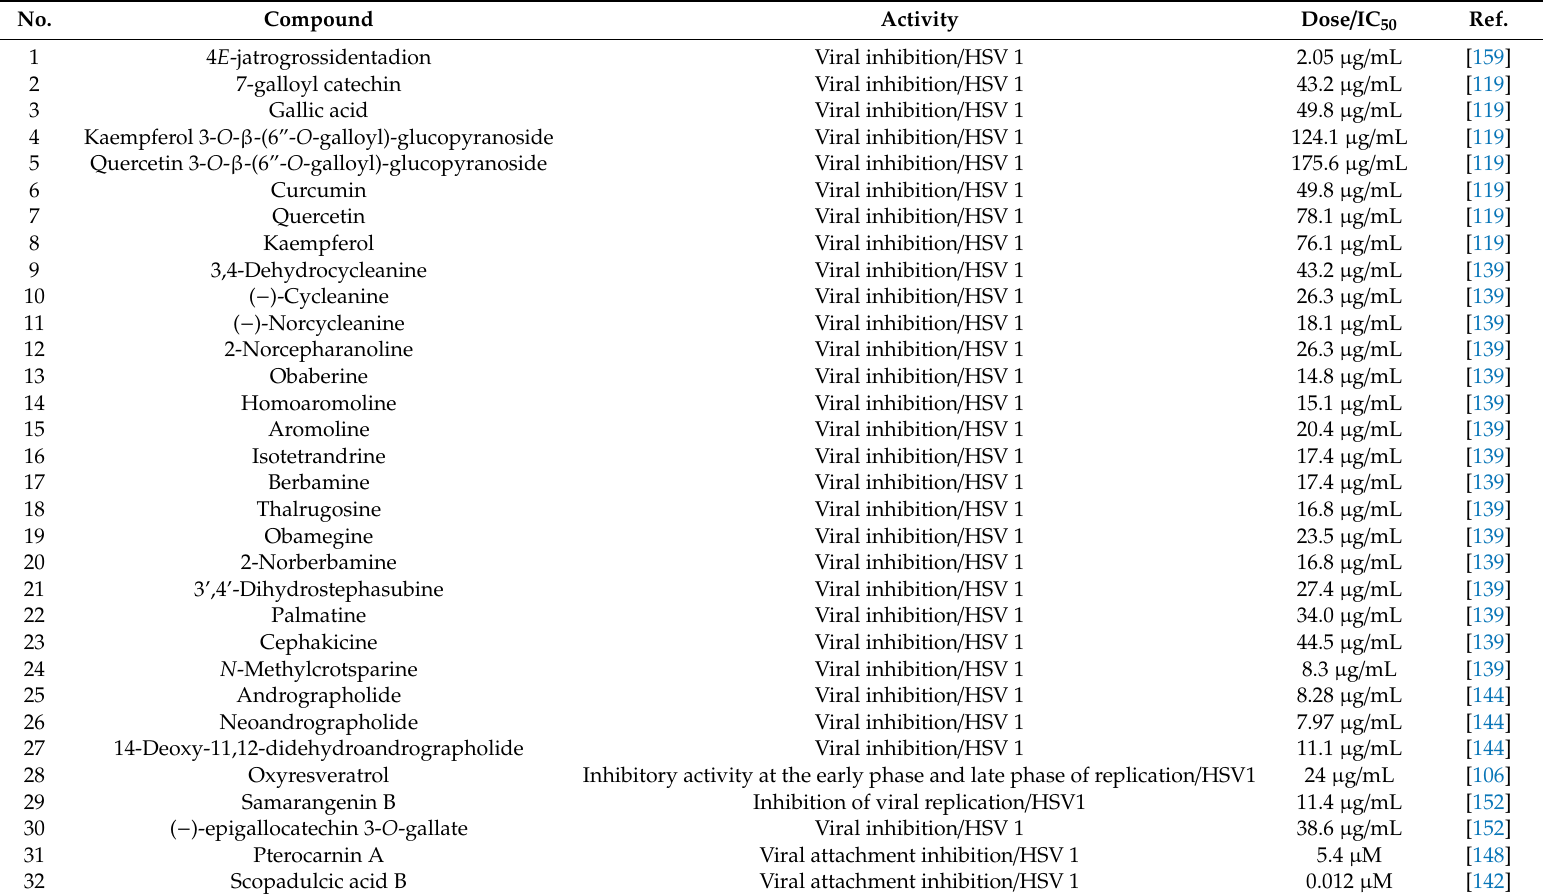
Table 4. Bioactive compounds derived from plants with anti-HSV